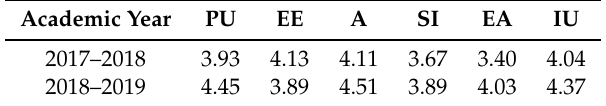
Figure 9. Indicators’ Values for both Academic Years 2017-2018 and 2018-2019. Table 2. Obtained values for both Academic Years 2017–2018 and 2018–2019.